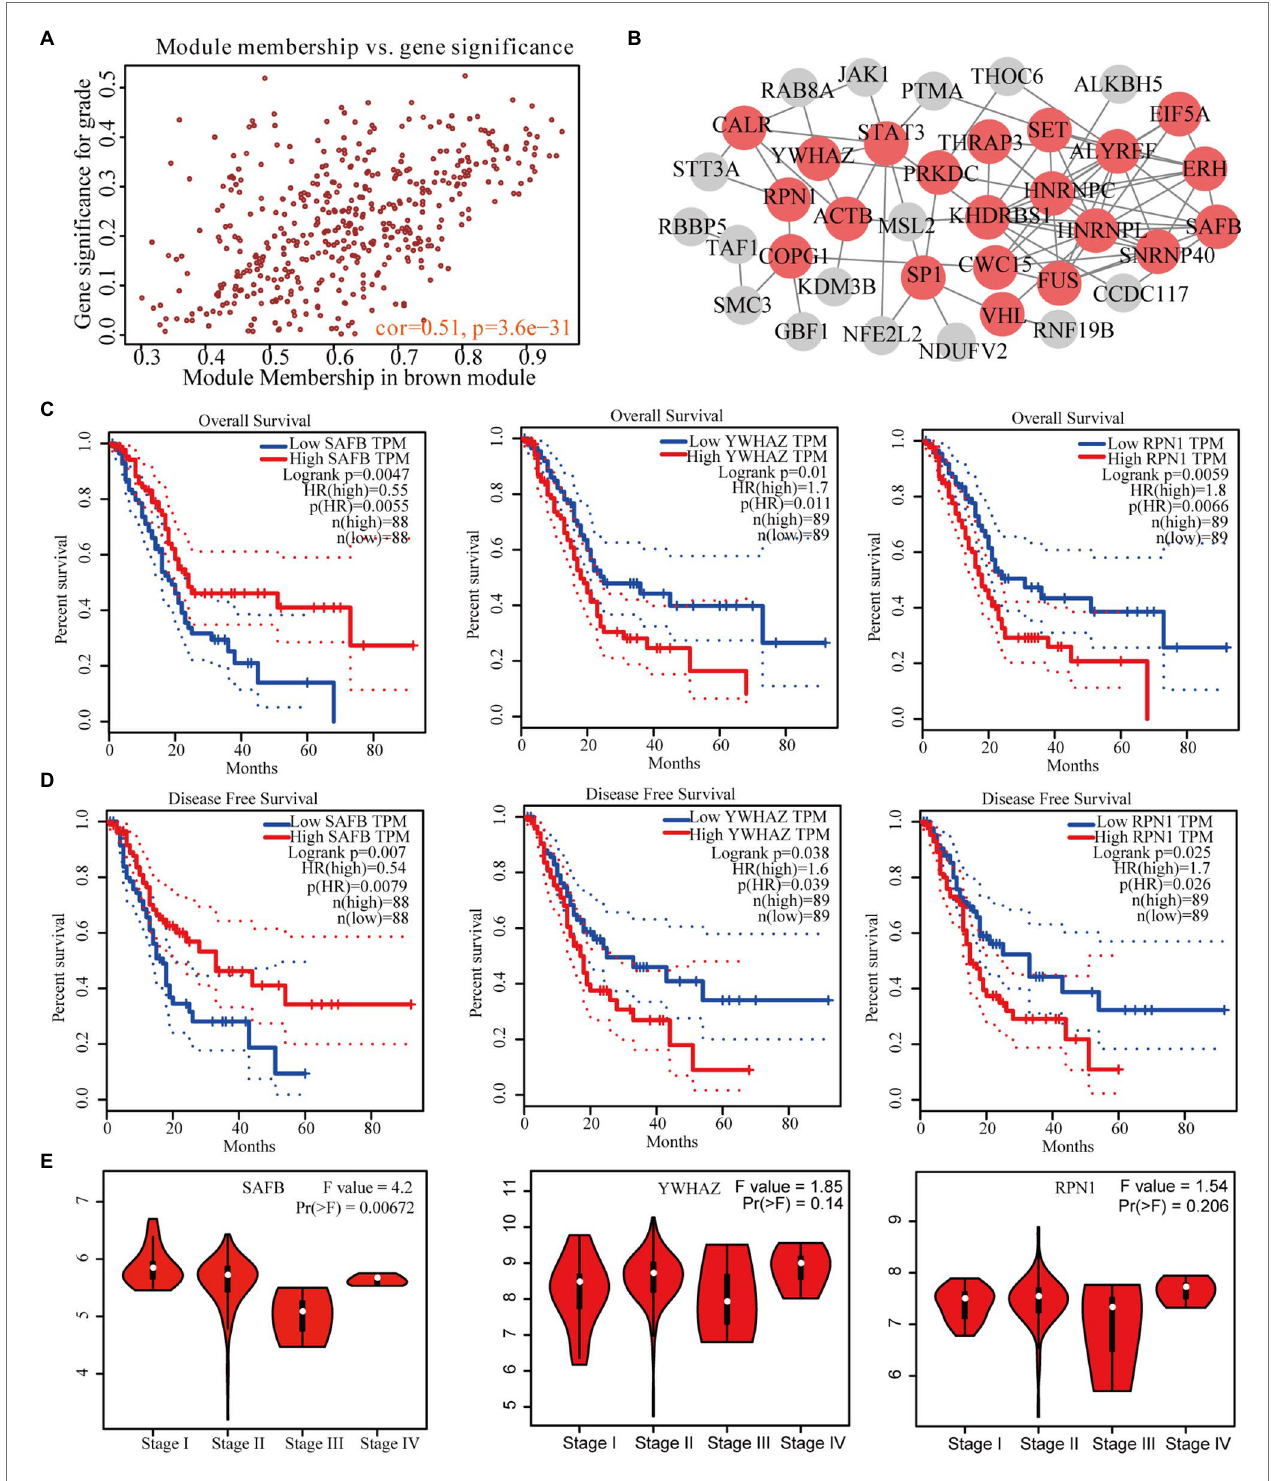
FIGURE 3 | Identification of real hub genes significantly associated with PAAD prognosis and progression. (A) Scatter plot of MEs in the brown module. (B) Protein–protein interaction (PPI) network of weighted gene co-expression network analysis (WGCNA)-derived hub genes (the red nodes represent the candidate genes in the PPI network). (C) Overall survival (OS) and (D) disease-free survival (DFS) curves of candidate genes in PAAD gene expression profile interactive analysis (GEPIA). (E) Correlation between prognosis-related candidate genes and PAAD